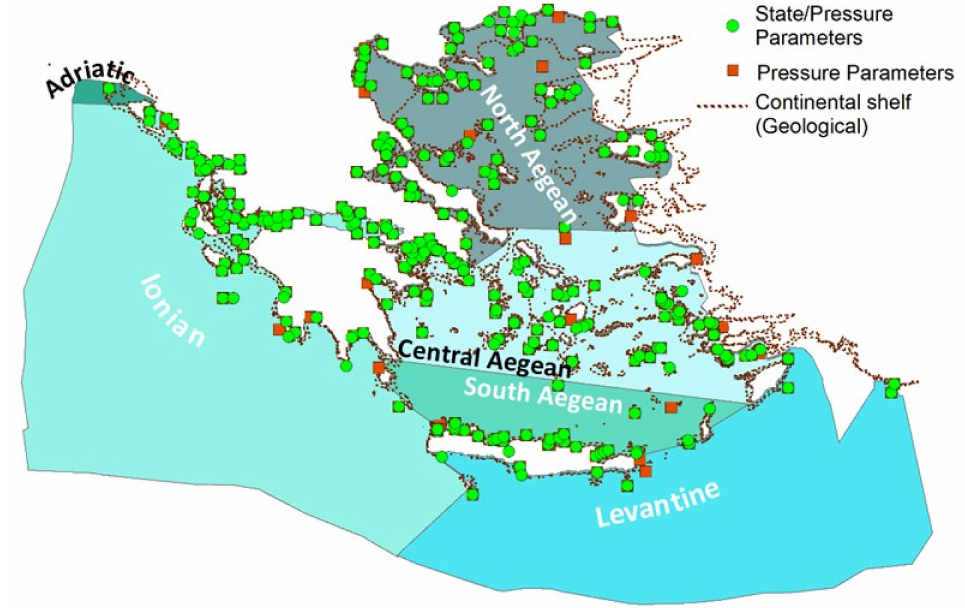
Figure 5. Integrated Greek Monitoring Network depicting all monitoring stations (i.e., WFD, open seas MSFD, Natura 2000, Data Collection Framework, Mytimed, and Posidon stations) in which parameters are measured for state and/or pressure